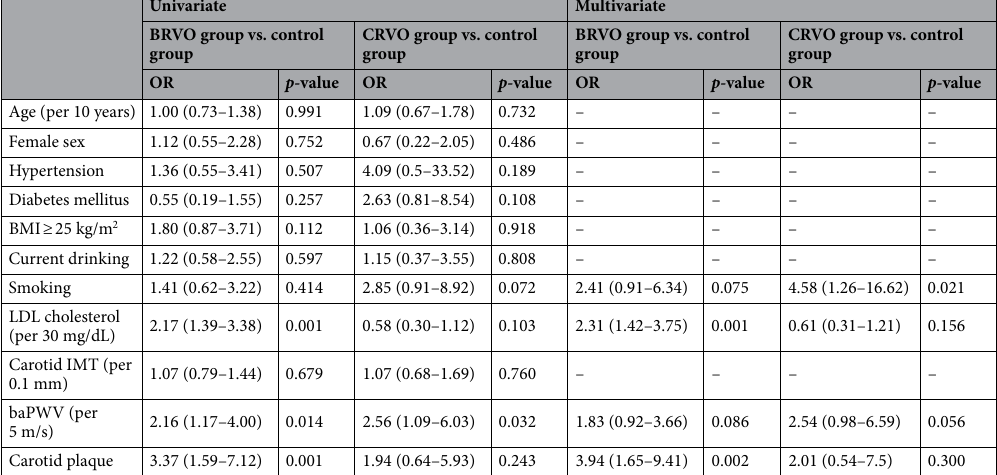
Table 3. Multinomial regression for predictors of CRVO and BRVO. baPWV brachial-ankle pulse wave velocity, BMI body mass index, BRVO branch retinal vein occlusion, CI confidence interval, CRVO